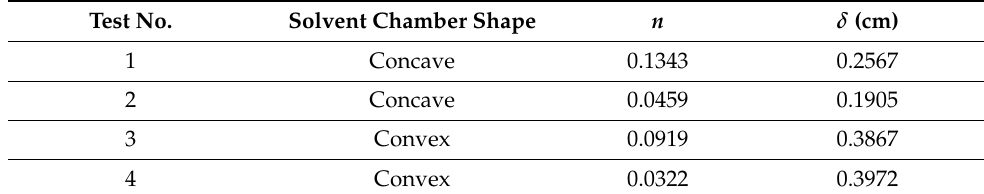
Figure 11. Actual transition region thickness values for the experimental cases presented by Ma et al. [3].